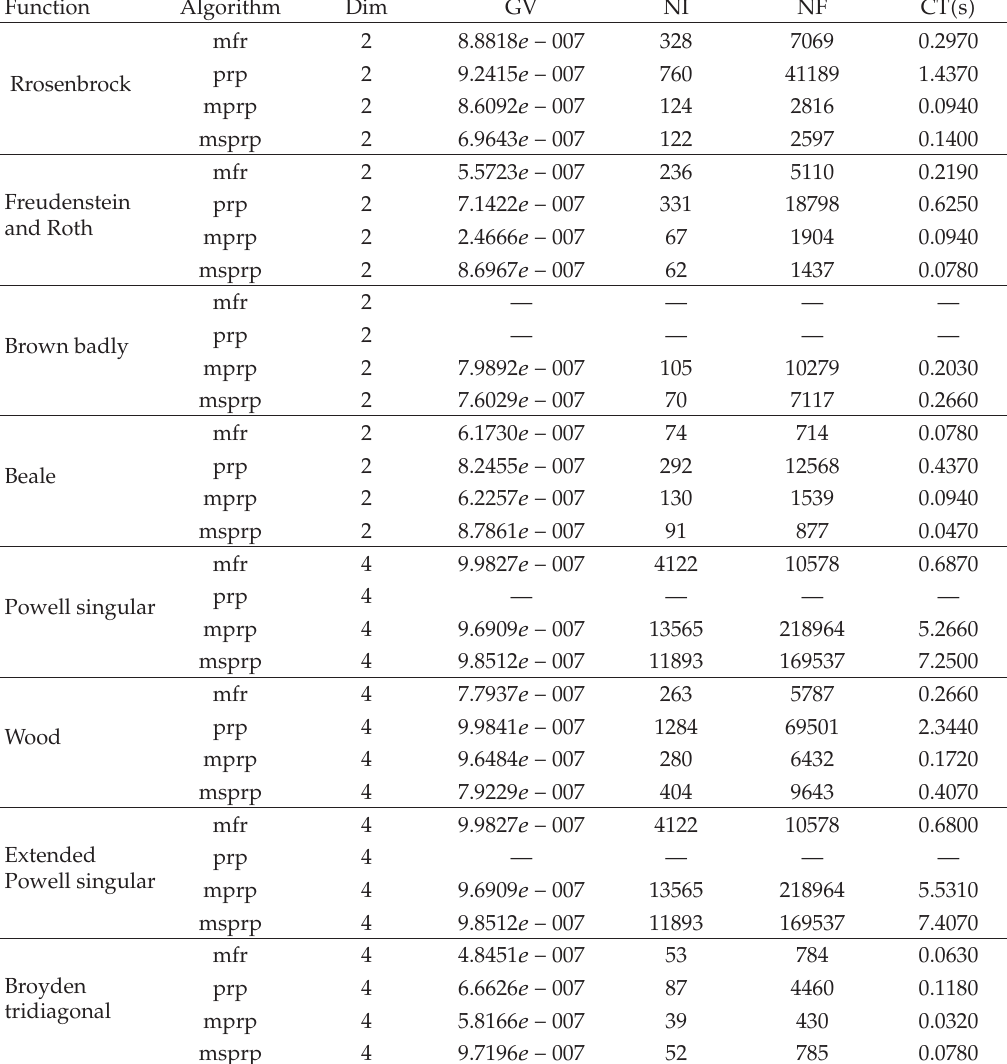
Table 1: Comparison of e ffi ciency with the other